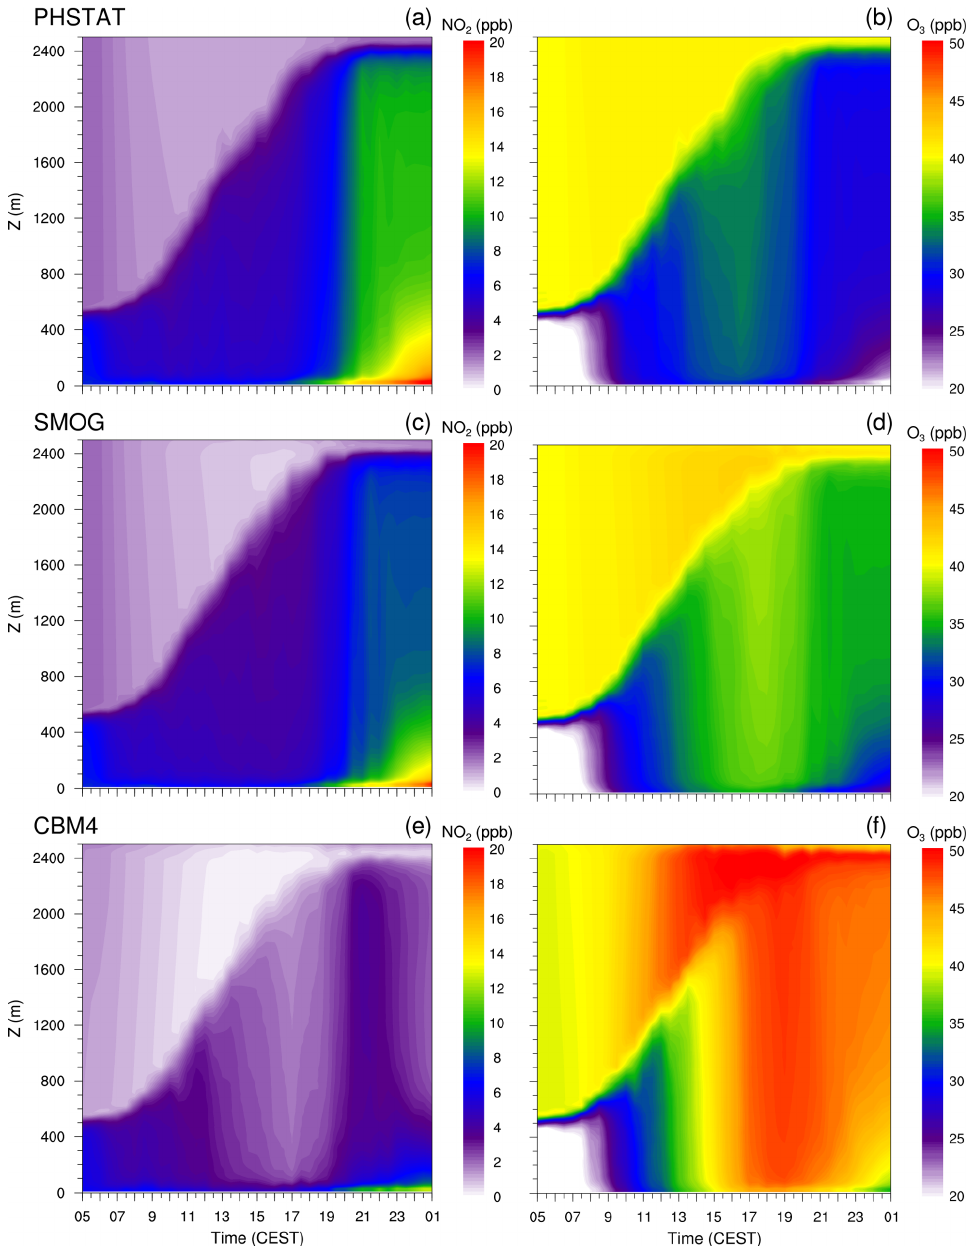
Figure 9. Time–height cross section of half-hourly averaged NO 2 , and O 3 concentrations simulated with the PHSTAT, SMOG and CBM4 mechanisms from 05:00CEST (17 July 2017) to 01:00CEST (18 July 2017) at Hardenbergplatz. The left column (a, c, e) shows NO 2 , and the right column (b, d, f) shows O 3